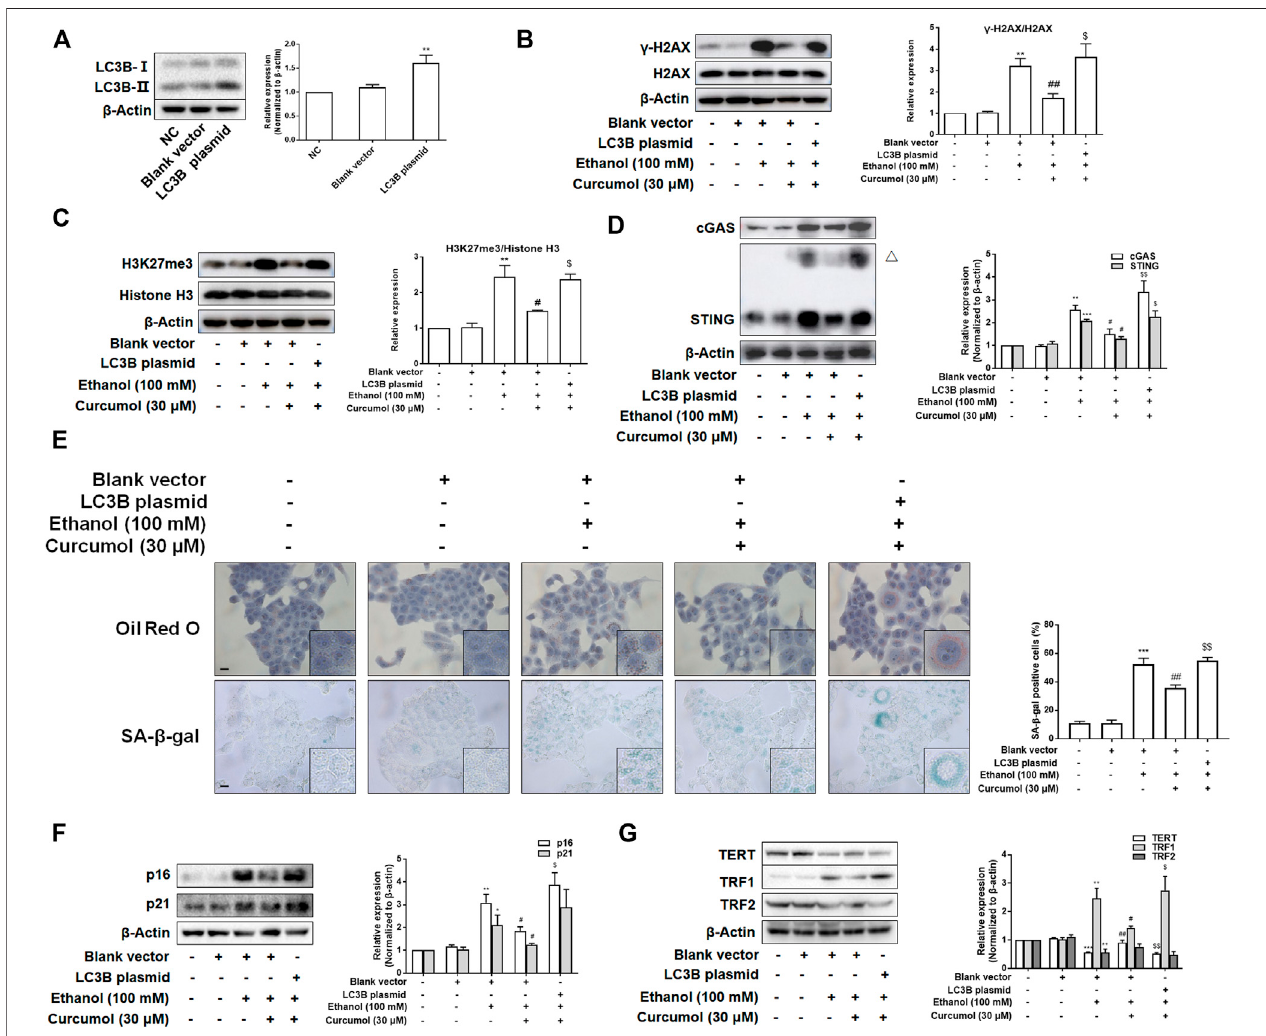
FIGURE 6 | Overexpression of LC3B attenuated curcumol ’ s effect on ethanol-induced cellular senescence in LO2 cells. (A – D) Western blot analyses of the transfection ef fi ciency of LC3B plasmid and the expression of γ -H2AX, H3K27me3, cGAS, and STING in LO2 cells, n = 3. STING blots were performed under non- reducingconditions. △ STING dimer.Dataarerepresentedasmean±SD.Signi fi cance:** p < 0.01and*** p < 0.001versusblankvectorgroup, # p < 0.05and ## p < 0.01 versusblankvector +ethanol group, $ p < 0.05and $$ p < 0.01versusblankvector +ethanol+ curcumol group. (E) Representative images ofoilred O stainingand SA- β -gal staining (scale bar, 100 μ m) in LO2 cells, n = 3. Data are represented as mean ± SD. Signi fi cance: *** p < 0.001 versus blank vector group, ## p < 0.01 versus blankvector+ethanolgroup, $$ p < 0.01versusblankvector+ethanol+curcumol group. (F and G) Westernblotanalyses ofproteinexpression ofsenescencemarkers (p16and p21) and telomereand telomerase related factors (TERT, TRF1, and TRF2) protein levels in LO2 cells, n = 3. Data are represented asmean ±SD. Signi fi